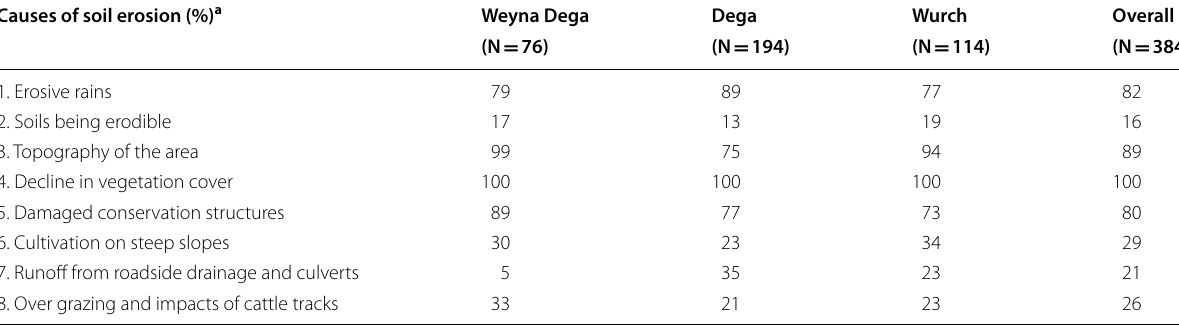
a Percentage does not add up to 100 because of multiple responses